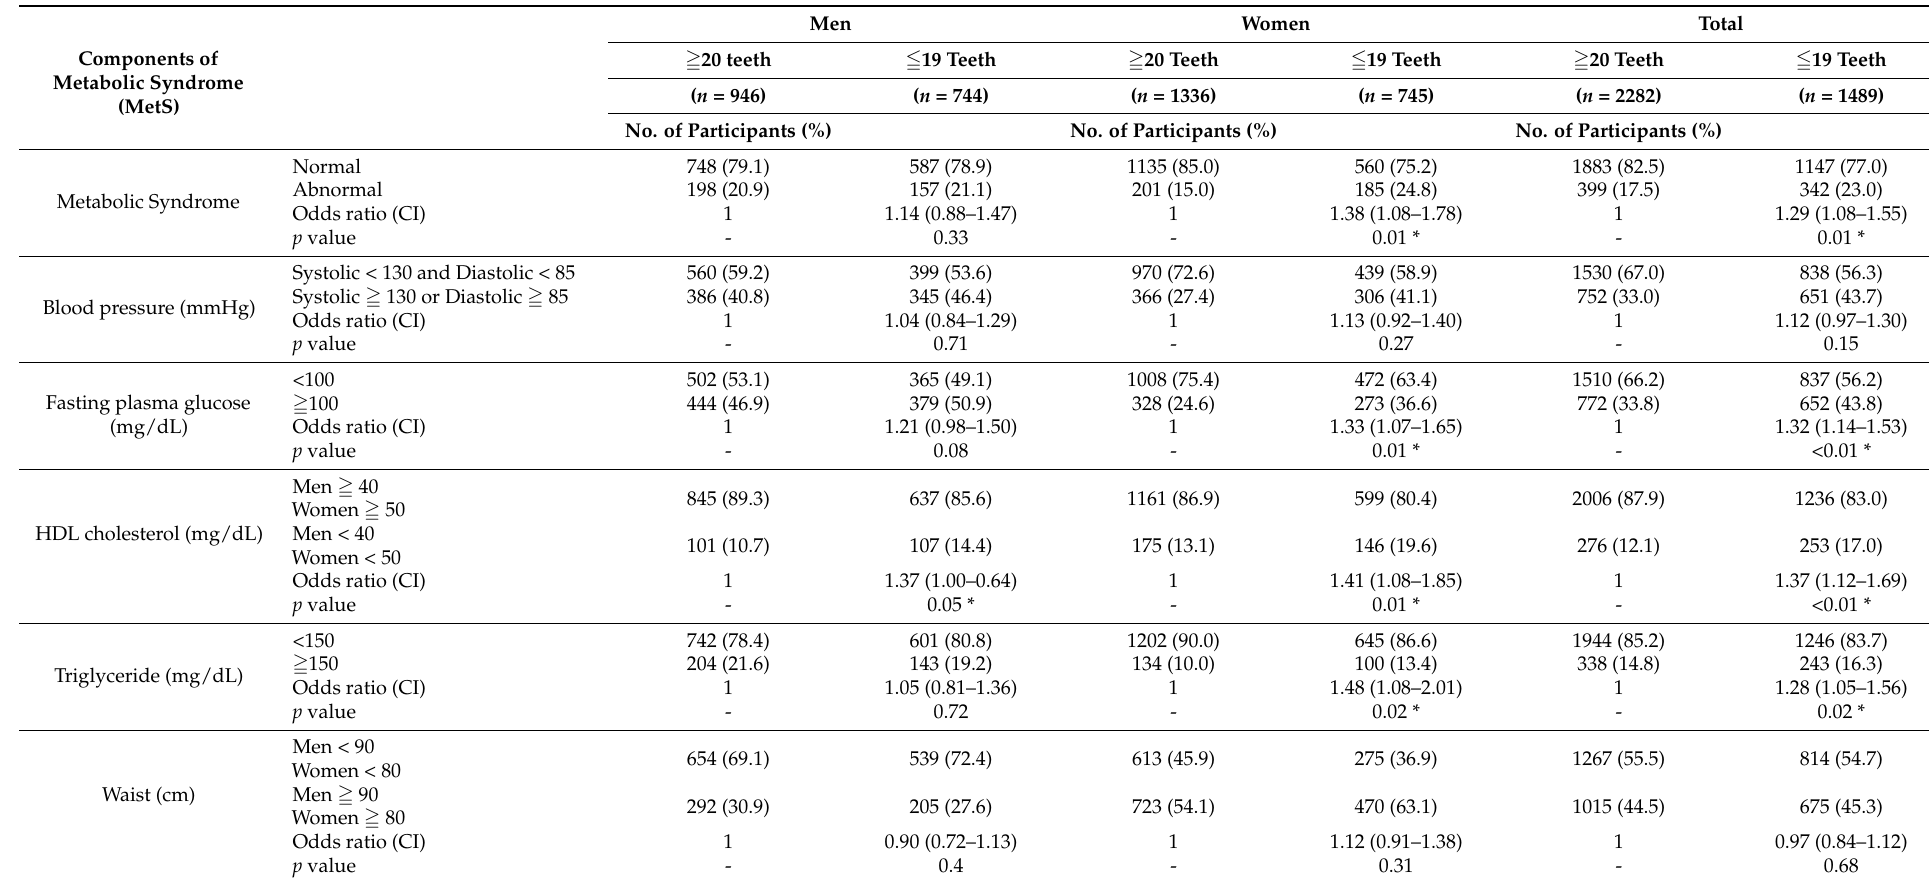
Table 2. Association between the number of teeth ( (cid:61) 20 teeth or (cid:53) 19 teeth) and prevalence of abnormal MetS components and diagnosis with